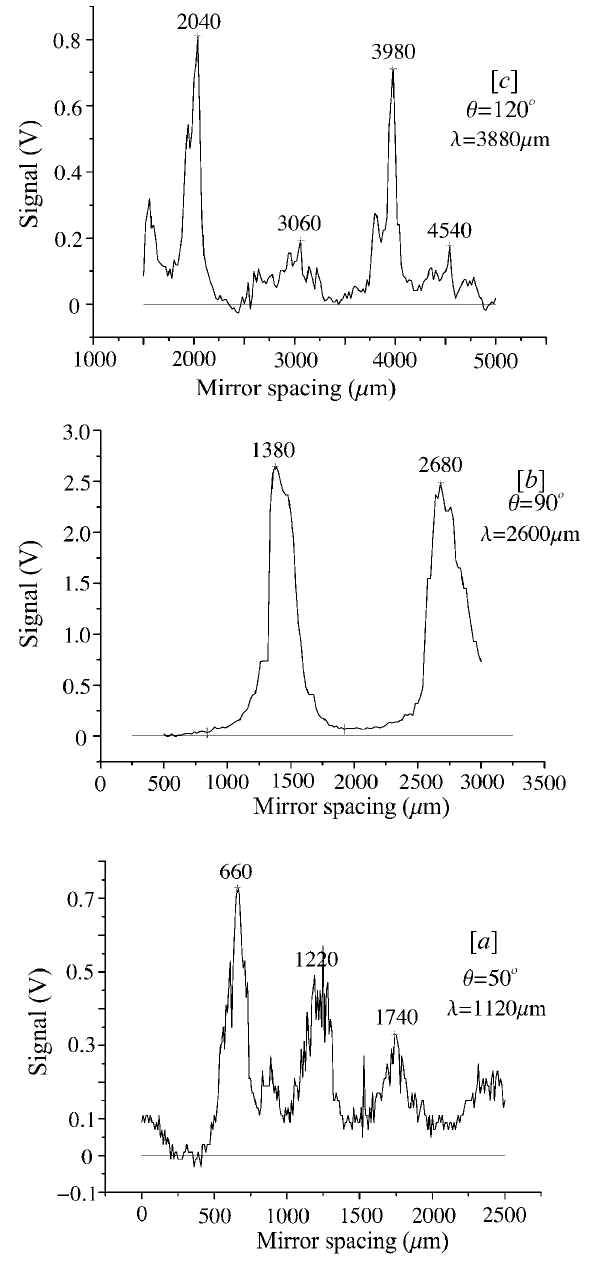
FIG. 2. Three Fabry-Perot scans taken with the mirrors at (a) 50 ± , (b) 90 ± , and (c) 120 ± .